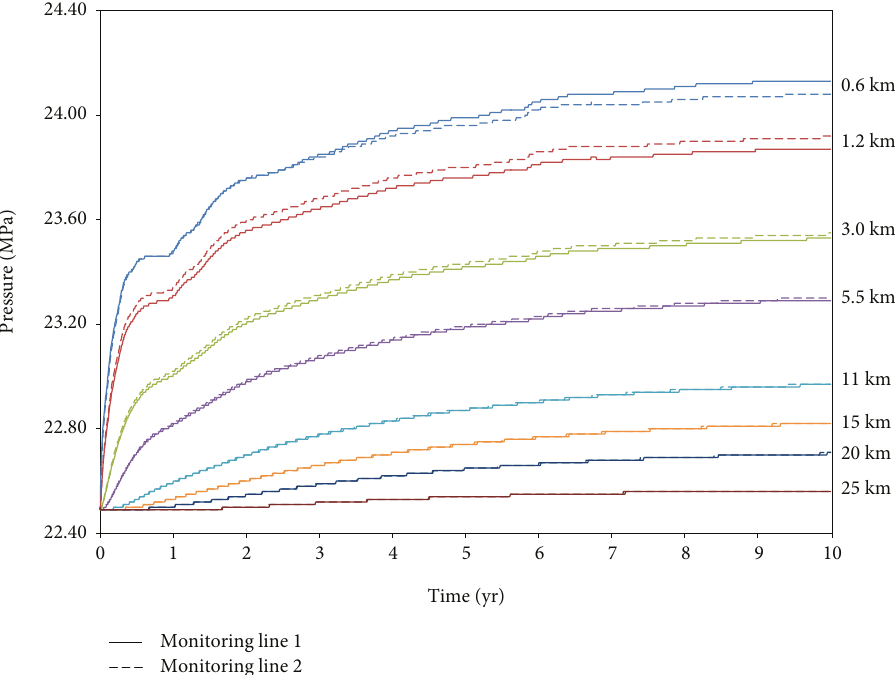
Figure 25: Pressure changes at the pressure monitoring points during injection in the 2-well model.